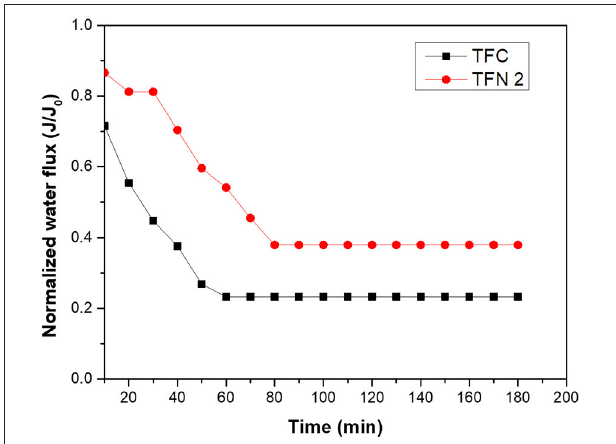
FIGURE 10 | CTAB filtration of pristine TFC and TFN 2 membranes.